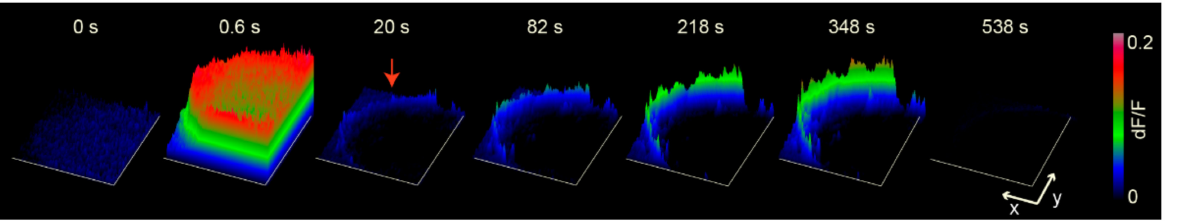
Figure 6. Calcium dynamics on 20 Hz stimulation. Time-lapse sequence of fluorescent images showing the fast calcium transient invading the soma followed by the persistent calcium transient in the periphery (red arrow). Stimulation occurred at time = 0 s. The time after stimulation is indicated above each snapshot. The color code indicates the amplitude of the normalized (dF/F) fluorescence of the calcium sensor. Obtained with permission from